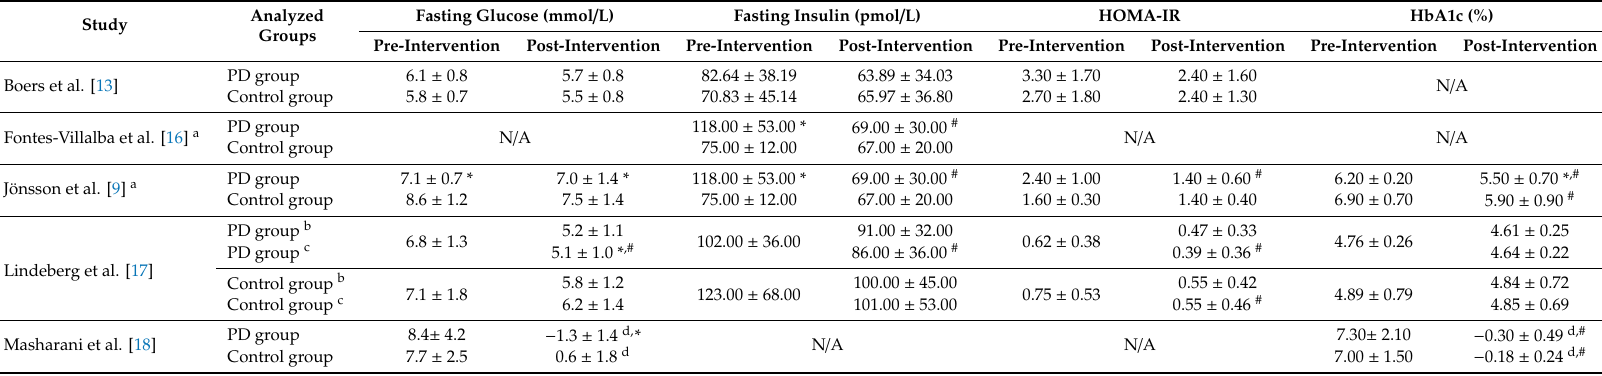
Table 3. E ff ect of the Paleolithic diet on fasting glucose and insulin levels, HbA1c, and HOMA-IR (mean ±